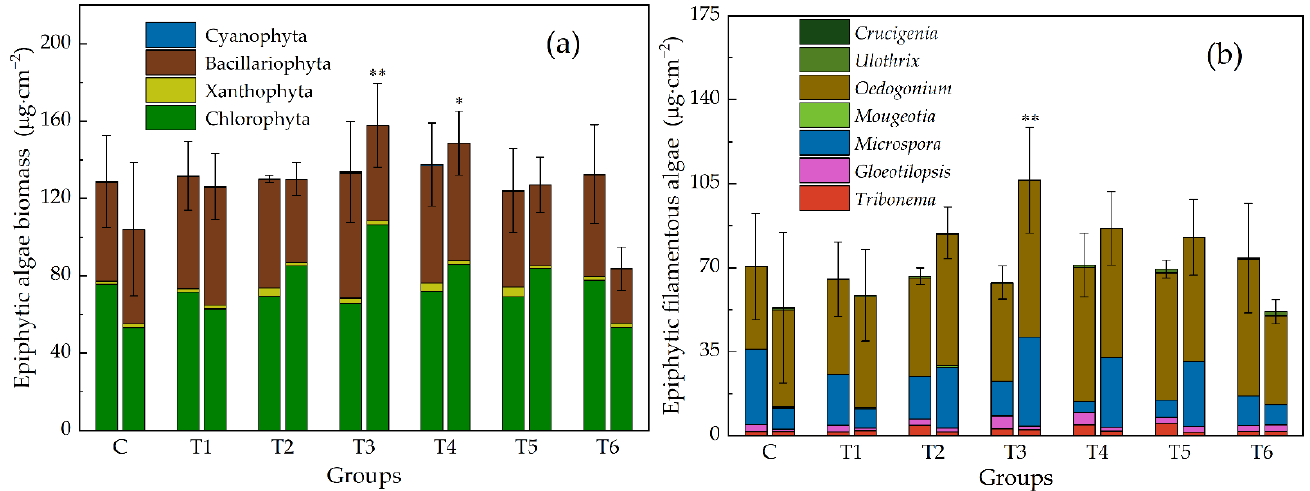
Figure 1. Biomass of epiphytic algae, ( a ) at phylum level, ( b ) epiphytic filamentous algae at genus level. Each group has two histograms (right: Initial; left: 7 d). Groups: C, control group; T1-T6, treatment groups, and the corresponding concentrations of ENR are 0.001, 0.2, 1.13, 6.33, 35.6, and 200 mg · L − 1 , respectively. Stars above the histogram show significant differences between control group and treatment groups (* p < 0.05, ** p < 0.01).